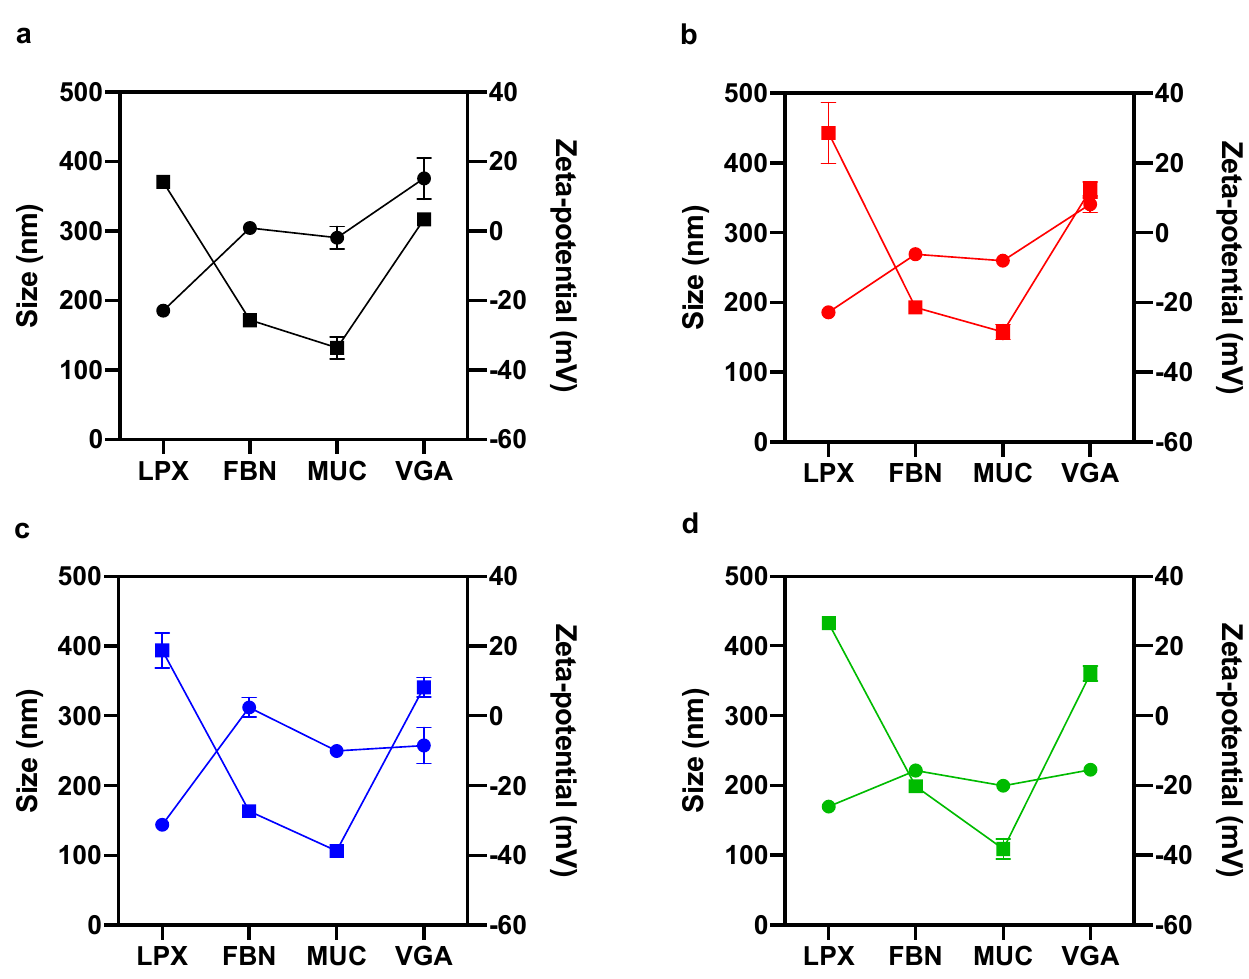
Figure 1. Size (circles) and zeta-potential (squares) of lipoplexes (LPX) before and after interaction with Fibronectin (FBN), mucin (MUC) and Val-Gly-Asp (VGA) tripeptide: LPX1( a ); LPX2 ( b ); LPX3 ( c ); LPX4 ( d ). Results are given as mean ± standard deviation of N = 5 independent replicates.